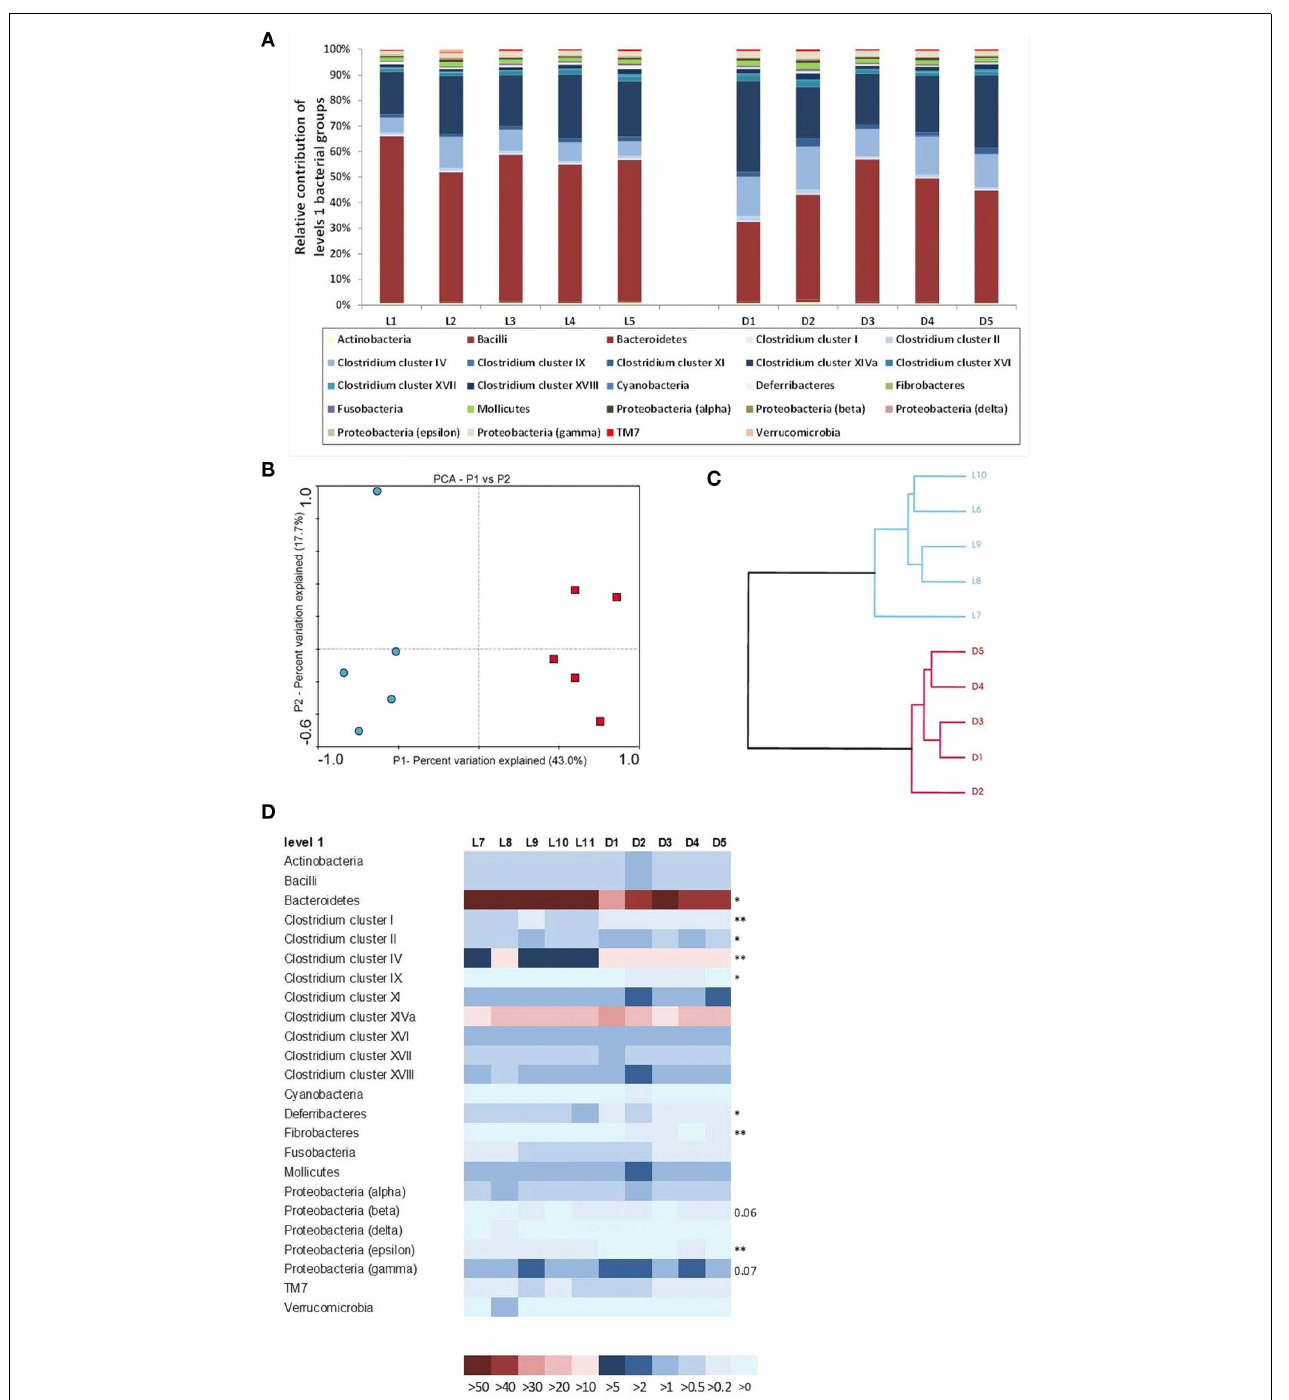
clustering visualizing the similarities of the phylogenetic MITChip fingerprints. Samples were hierarchically clustered based on the Pearson correlation. (D) Relative abundance of different bacterial classes expressed as the percentage of total probe signals ( n = 5/group). * P < 0.05, ** P < 0.01 determined by a two-tailed Student’s t